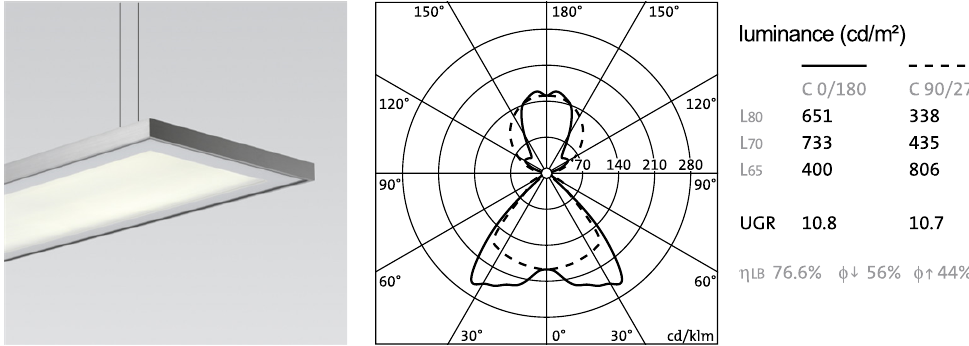
Figure 4. Image representation and light emission characteristics expressed in terms of a polar luminous intensity graph of the Quadrature ® 5MQ238D2H pendant office luminaires installed in the test offices. Additionally tabulated are the expected luminance values for different viewing angles, Unified Glare Rating (UGR) estimates, as well as the luminaire efficiency η LB including a breakdown of direct/indirect contributions